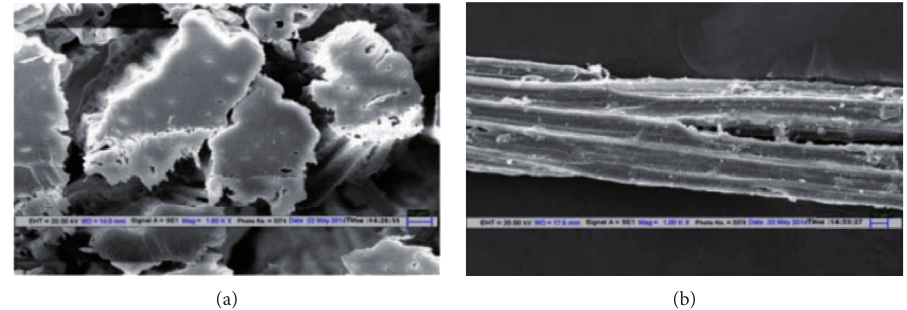
Figure 7: SEM images of (a) cross-sectional view and (b) longitudinal view of Kydia fibres [87].